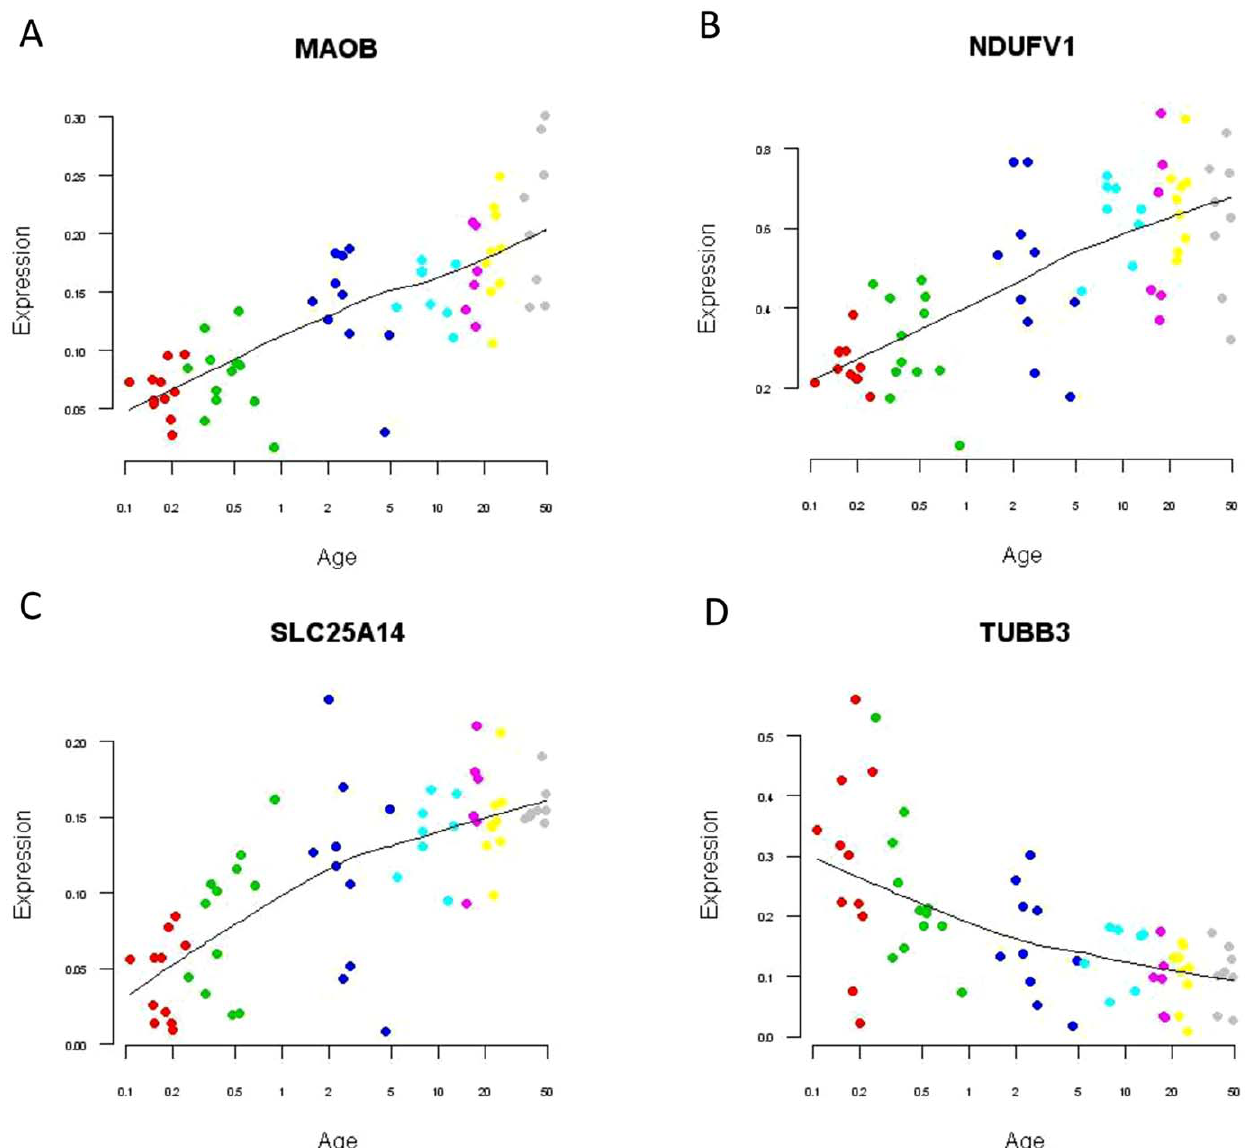
Figure 3. Quantitative PCR validation of mitochondrial genes. A scatter plot with a line of best fit demonstrates that each gene in the PFC shows either increase or decrease in expression across age (qv , 0.05). X-axis: Age (log 2 scale). Y-axis: Gene expression (log 2 scale). Subjects were color-coded as red: neonate (0–3 months), green: infant (3–12 months), blue: toddler (1–5 years), light blue: school age (6–13 years), pink: teenage (14–19 years), yellow: young adult (20–30 years), and grey: adult (31–50 years). A: MAOB (monoamine oxidase B), B: NDUFV1 [NADH dehydrogenase (ubiquinone) flavoprotein 1, 51 kDa], C: SLC25A14 (mitochondrial uncoupling protein 5), D: TUBB3 (tubulin beta-3 chain).